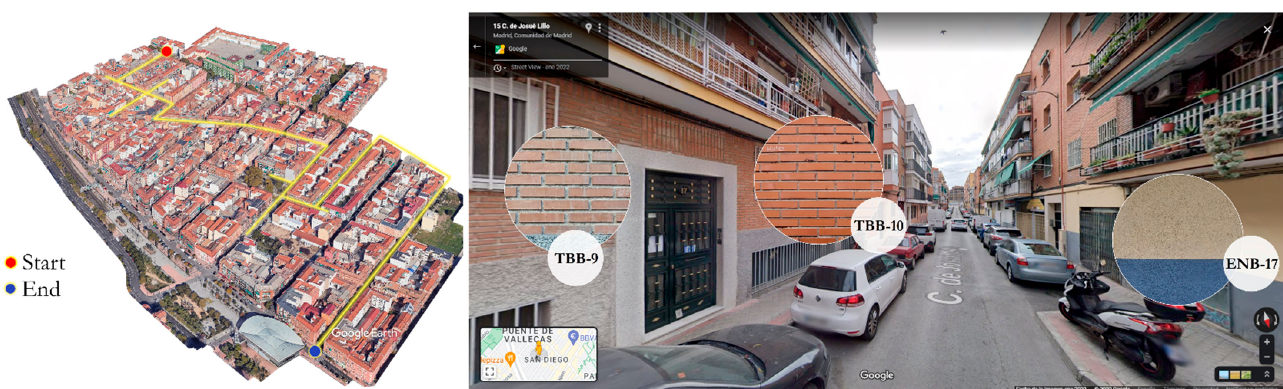
Figure 1. Images of the tasks carried out in the first campaign in the Picazo neighborhood. Left : definition of the route. Right : geolocation and close-ups of the materials. Image created from Google earth Studio and Google Maps.